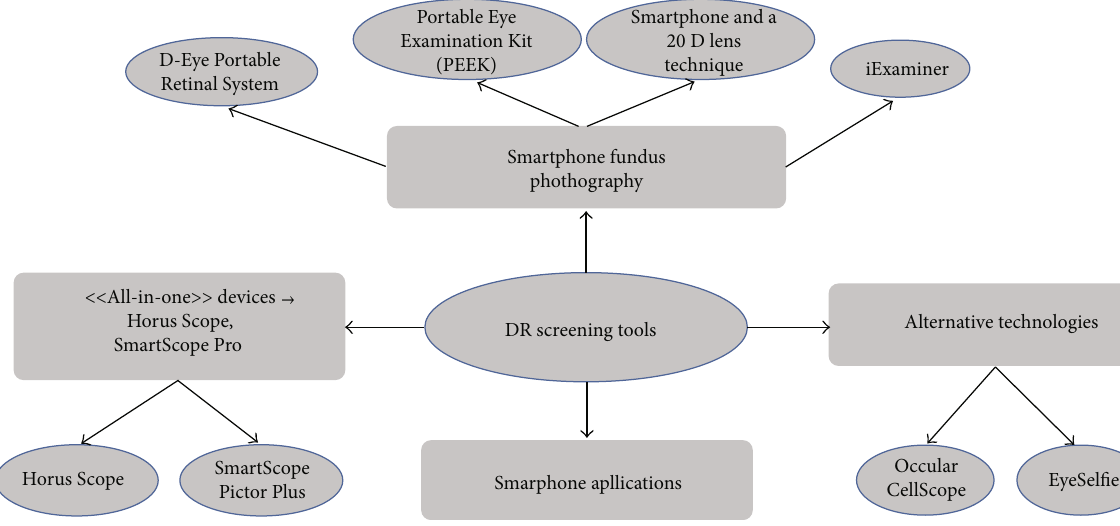
Figure 1: Telemedicine approaches for the screening or the diagnosis of diabetic